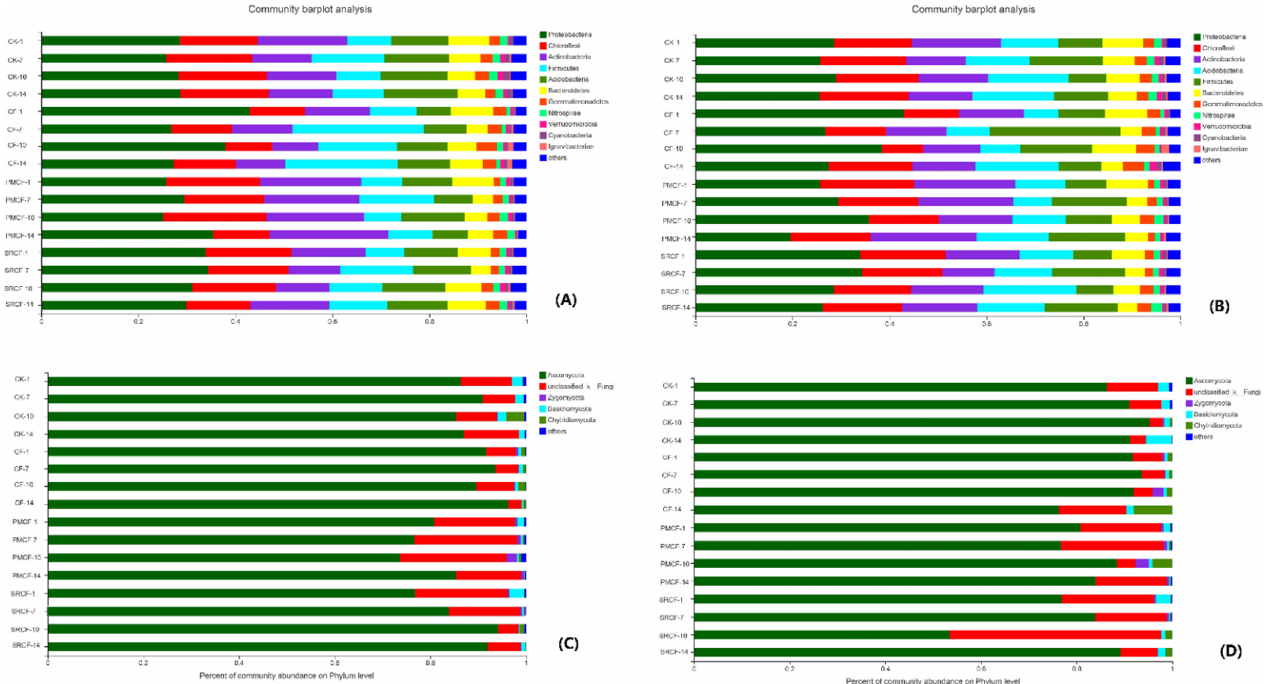
Figure 4. Relative abundance (%) of bacterial community at 1, 7, 10, and 14 days after incubation in soils collected from long-term experiment plots of the unamended control (CK), chemical fertilizers (CF), pig manure plus chemical fertilizer (PMCF), and rice straw plus chemical fertilizer (SRCF) under alternate wet–dry conditions ( A ) or permanent flooding ( B ). Relative abundance of bacterial community under AWD and PF is represented by ( A , B ), while for fungal community relative abundance by ( C , D ) under AWD and PF, respectively.